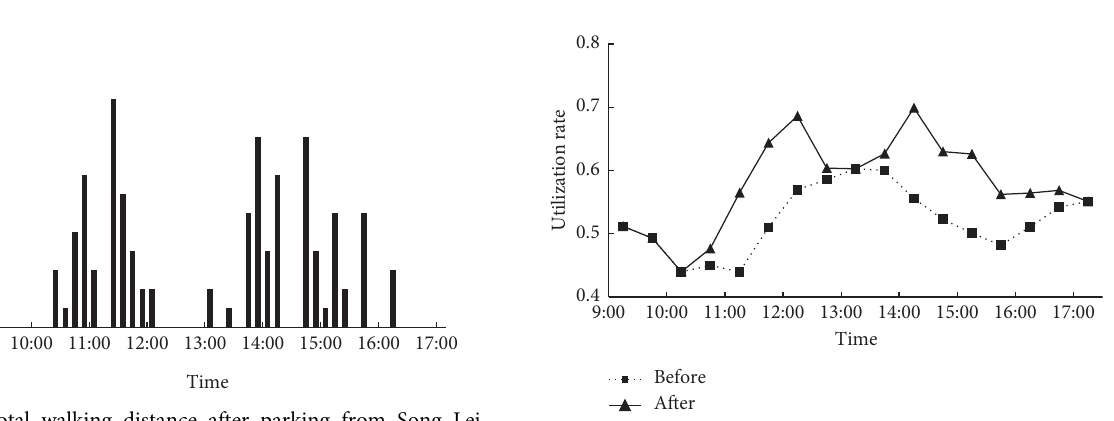
Figure 12: Utilizing rate of parking lots in Triumph Square.